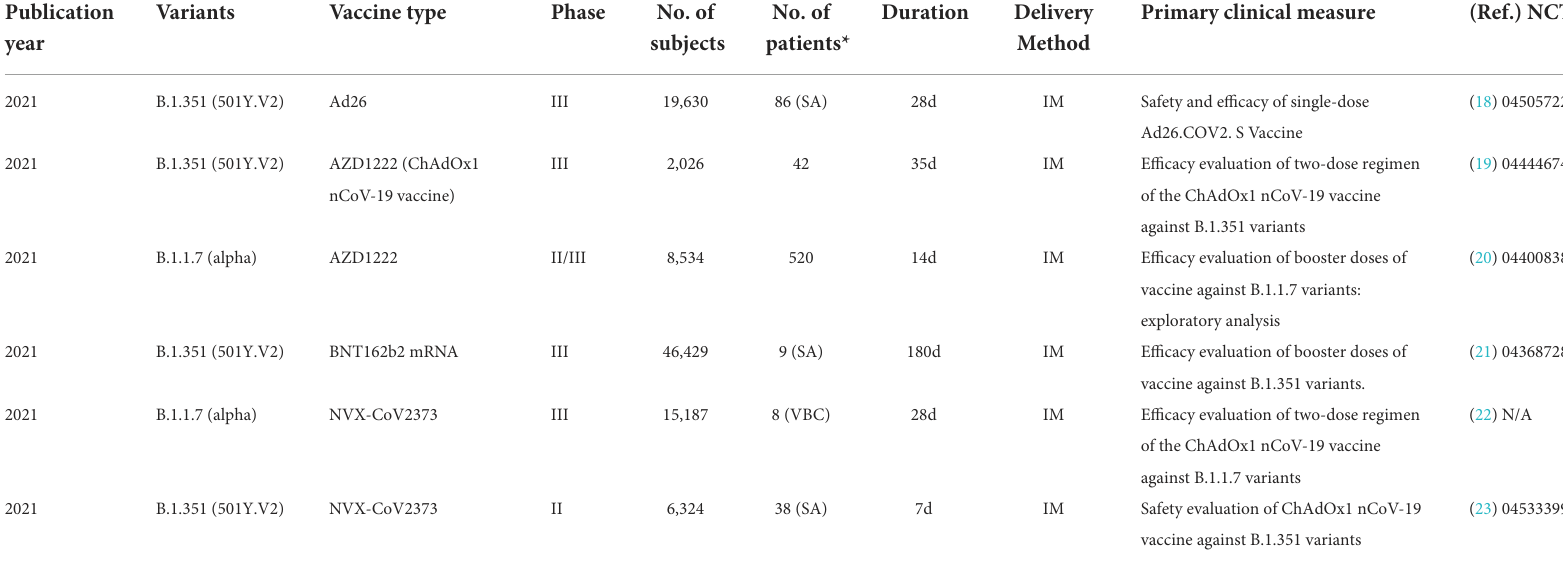
TABLE 6 Influential clinical trials investigating the safety and efficacy of diverse vaccines against SARS-CoV-2